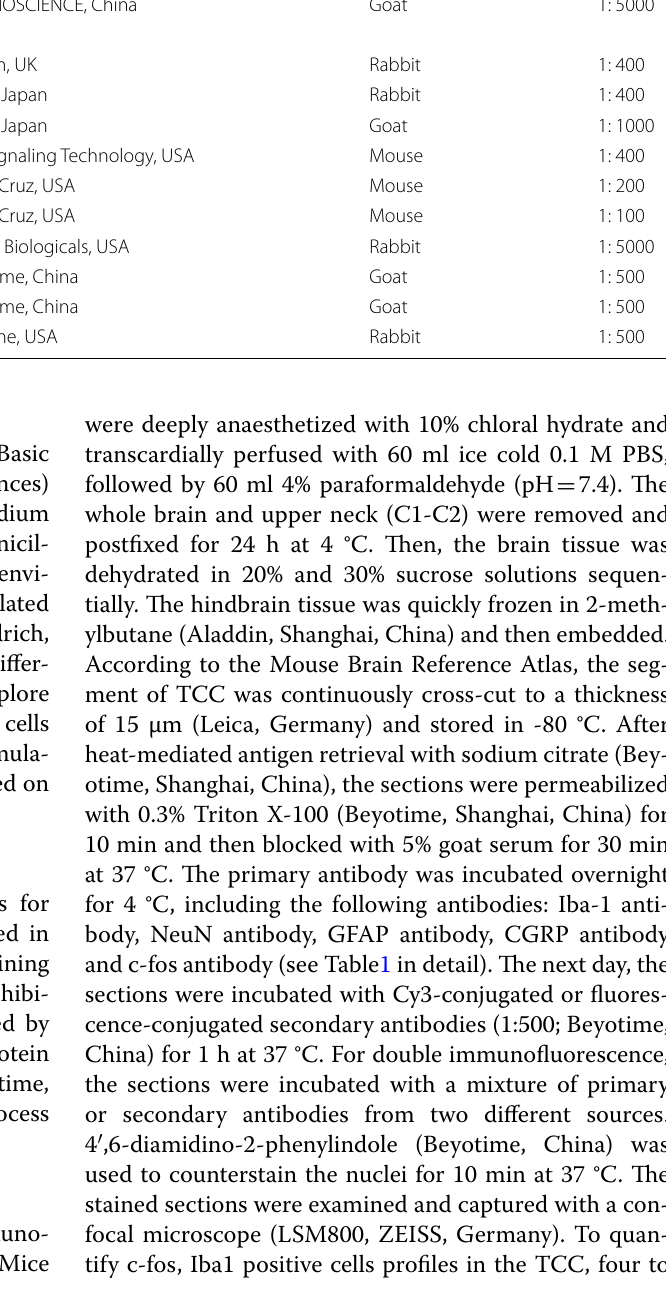
GAPDH Anti-rabbit IgG (HRP) For immunofluorescence